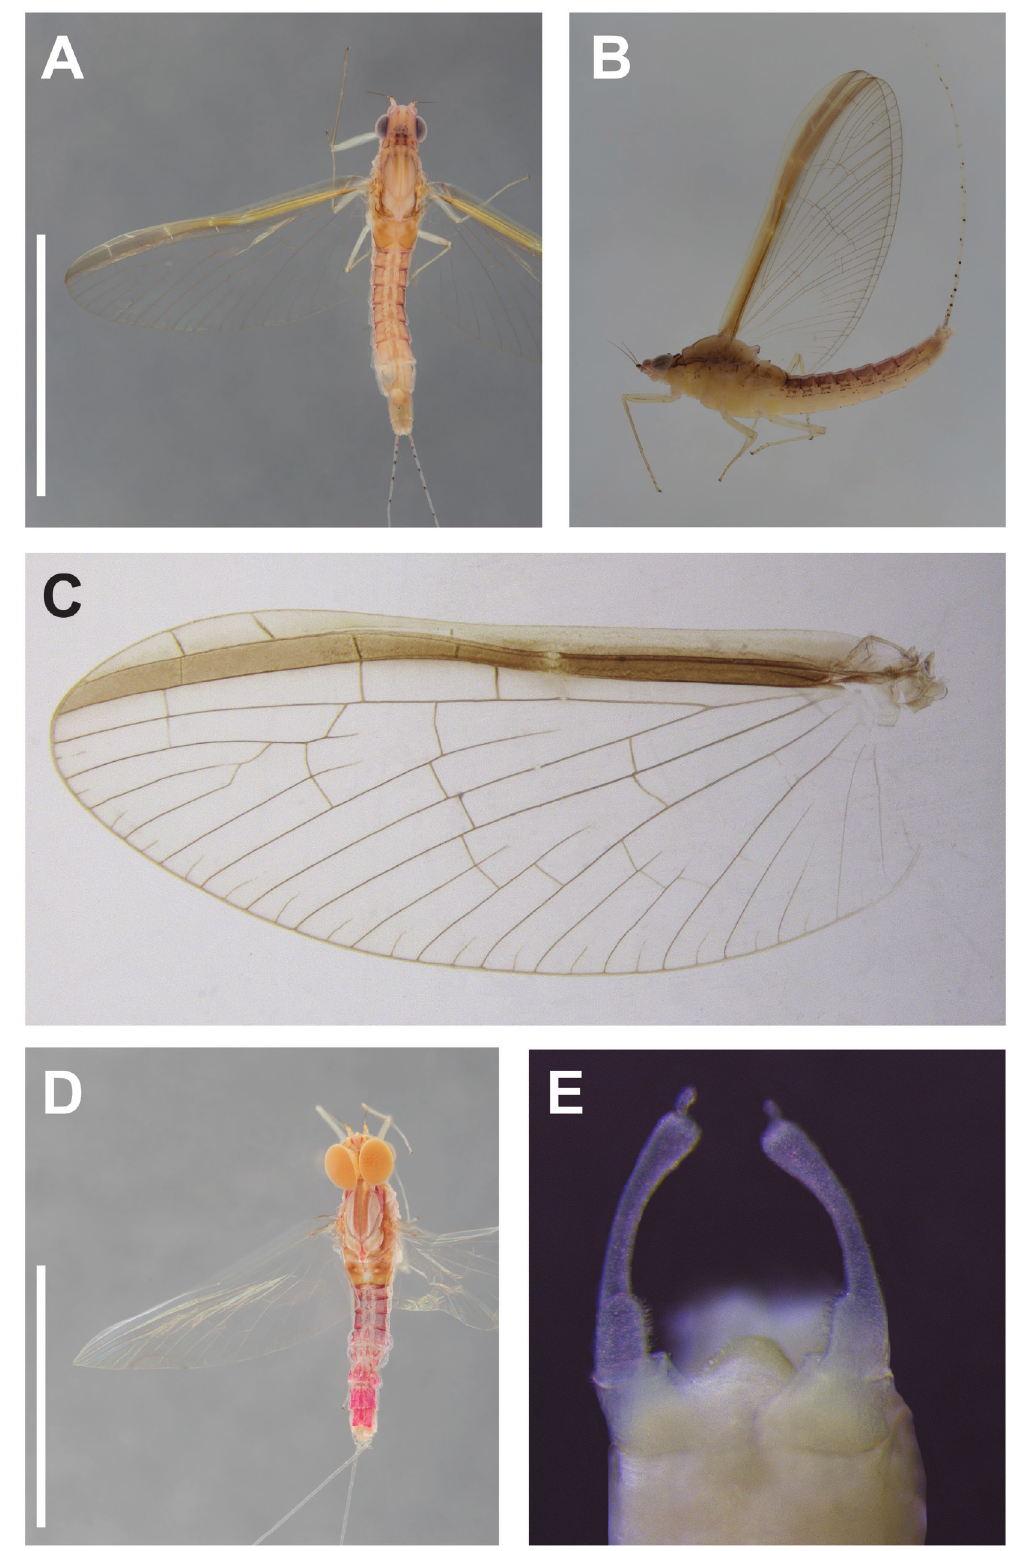
Fig. 7. Cloeon perkinsi , adults. A . ♀ habitus (dorsal). B . ♀ habitus (lateral). C . ♀ forewing. D . ♂ habitus (dorsal). E . ♂ gonopods. Specimens collected in Yessud haMa’ala, Israel. Scale bars = 5